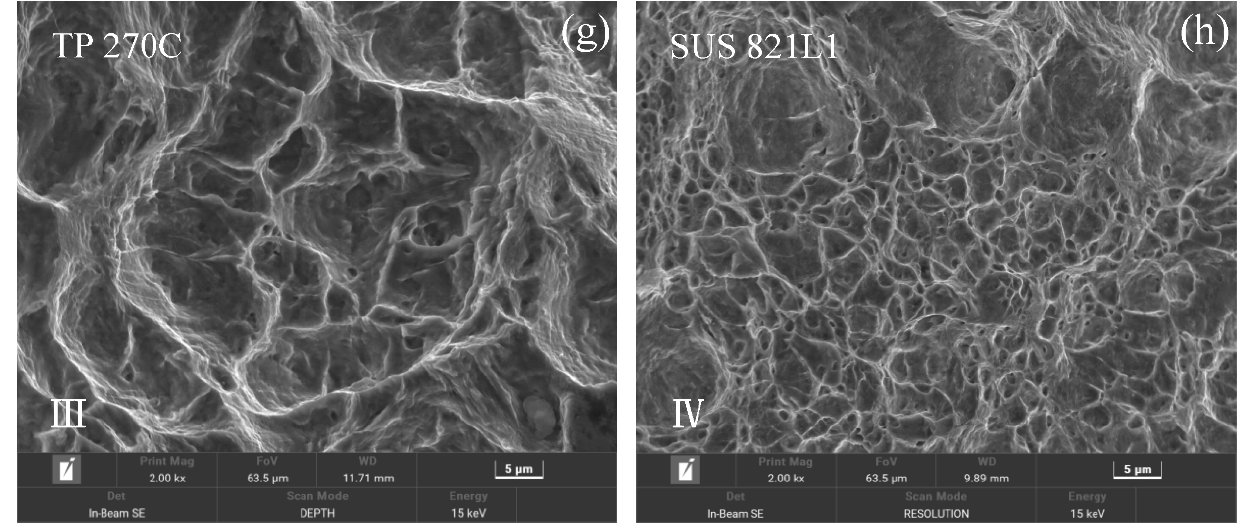
Figure 7. Fracture analysis: ( a ) TP 270C; ( b ) SUS 821L1; ( c ) weld seam, stand-off = 5 mm; ( d ) TP 270C side, stand-off = 5 mm, region Ⅰ ; ( e ) SUS 821L1 side, stand-off = 5 mm, region Ⅱ ; ( f ) weld seam, stand- off = 15 mm; ( g ) TP 270C side, stand-off = 15 mm, region Ⅲ ; ( h ) SUS 821L1 side, stand-off = 15 mm, region Ⅳ .